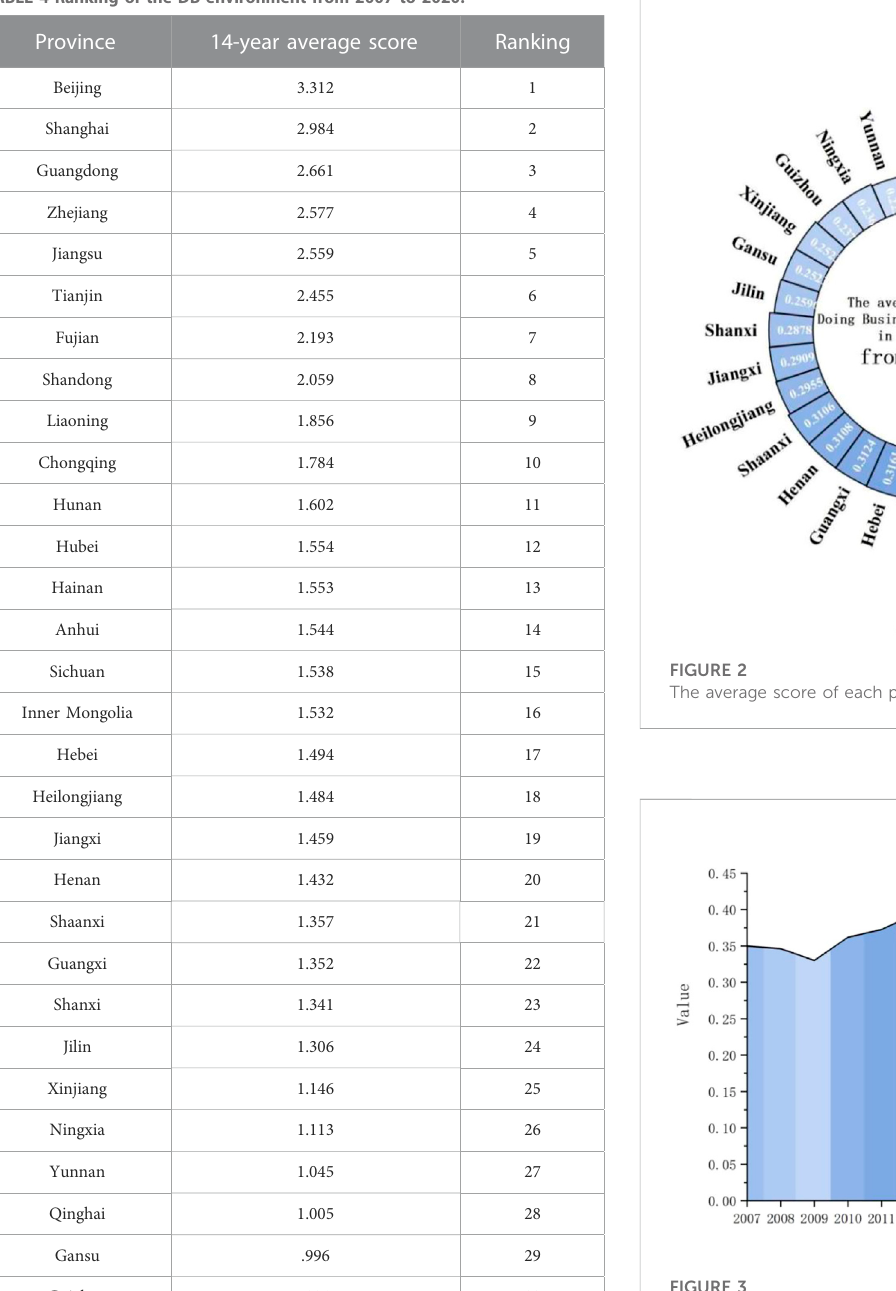
FIGURE 3 The National DB environment